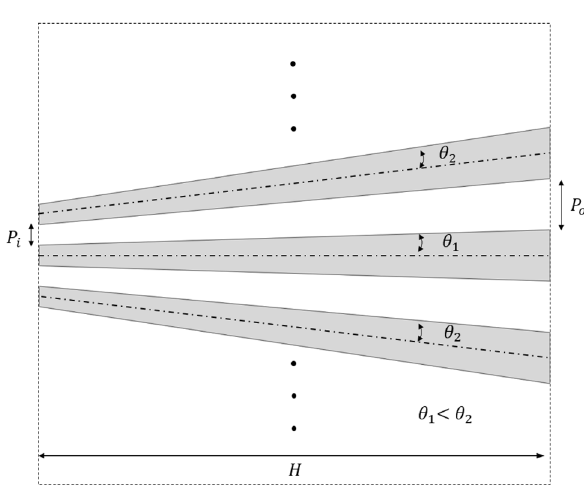
Figure 8. Schematic illustration of the design of constant period flat face